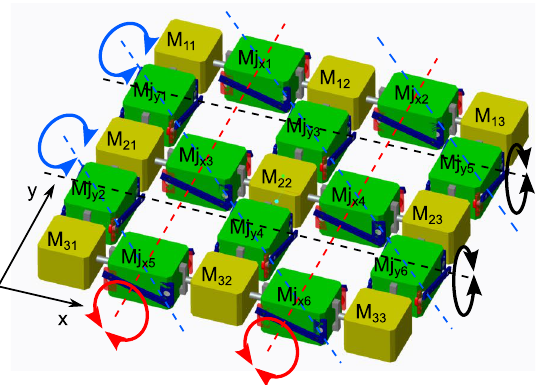
Fig. 4 The basic design of WORMESH-II for the isotropic modules formation (IMF)